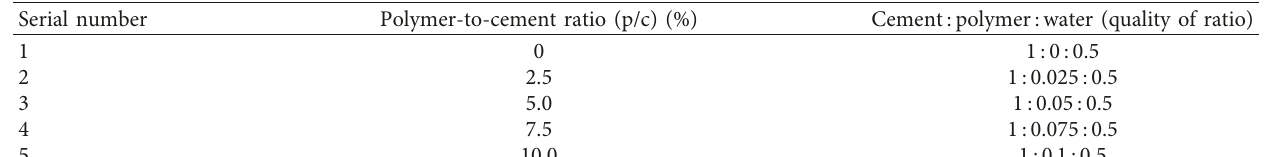
Table 3: Mixture ratios of modified styrene-acrylic emulsion cement slurries.